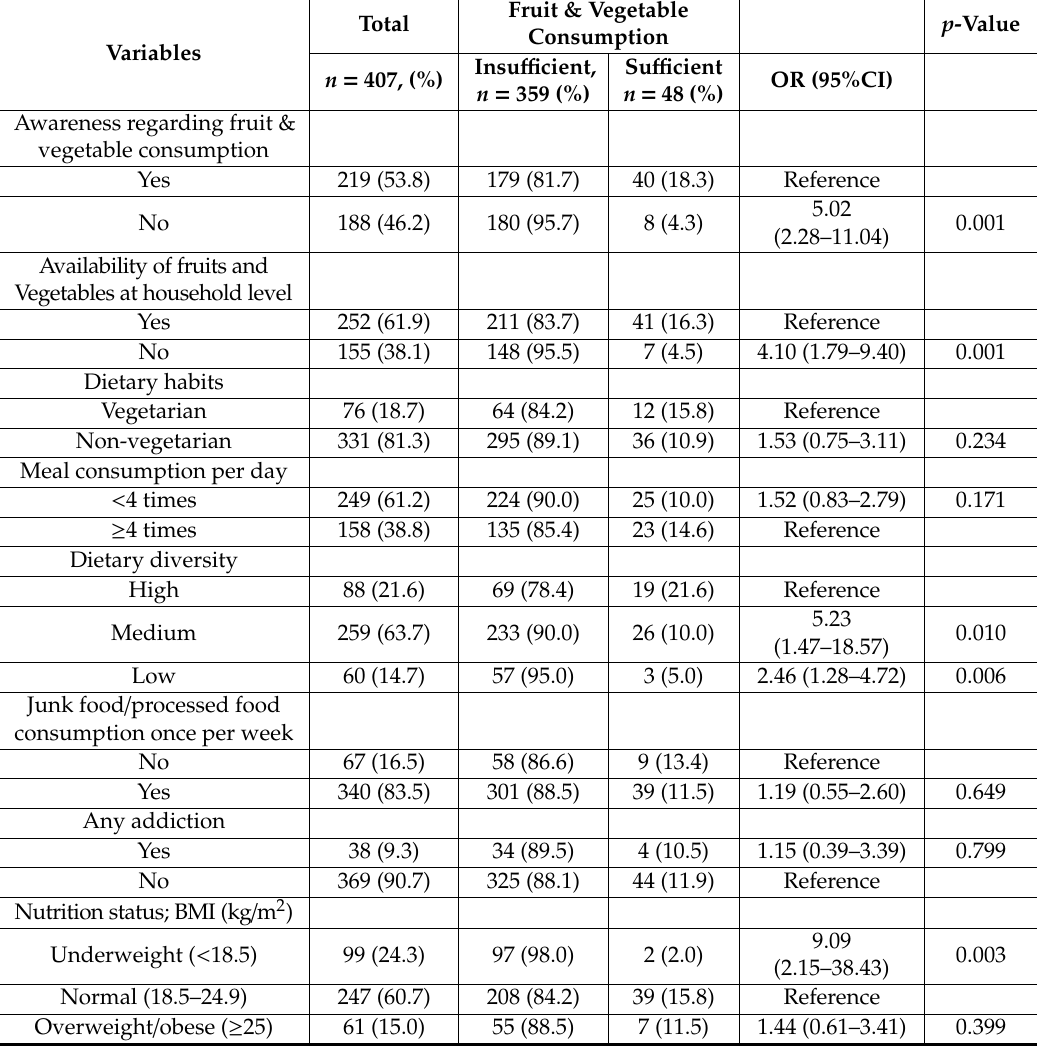
Table 2. Awareness, dietary-related factors and nutritional status of adolescent girls associated with fruit and vegetable consumption in rural communities in the Dhanusha district of Nepal, 2018. Fruit & Total